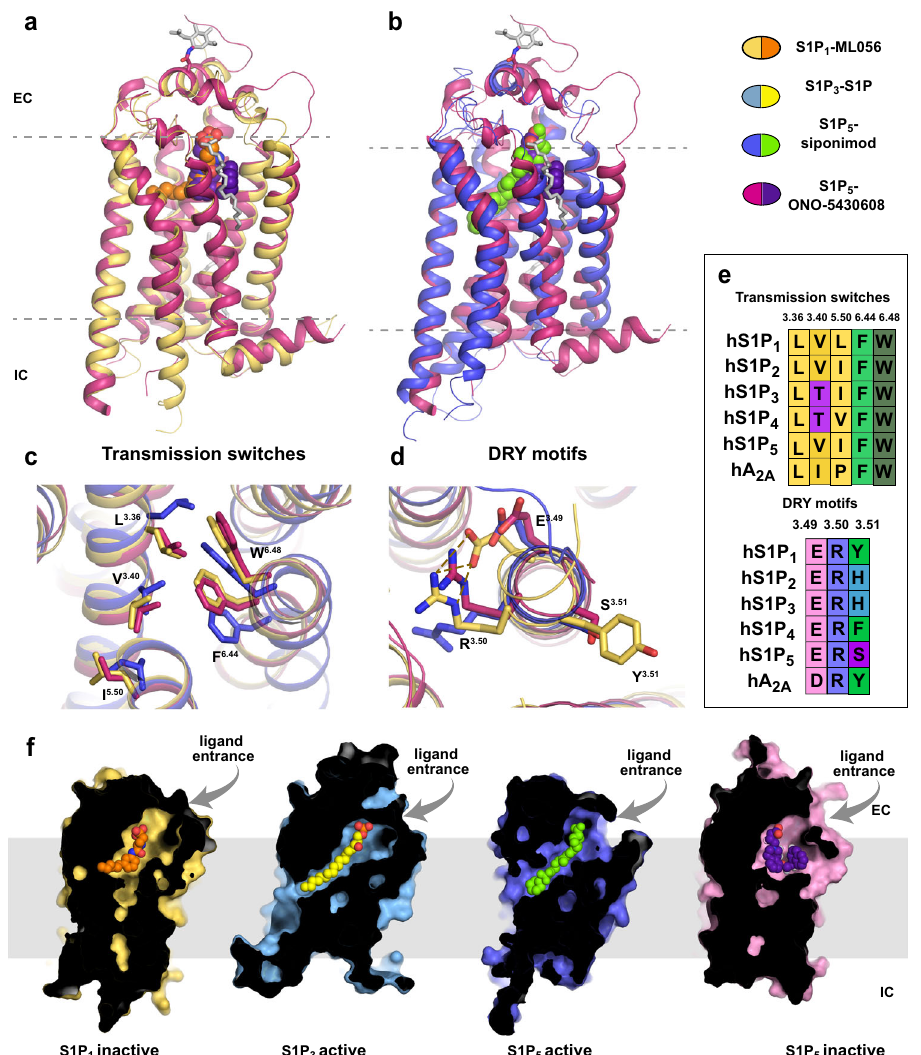
Fig. 1 | Structure of S1P 5 and its comparison with structures of other S1PRs: overview and conservative motifs. a Superposition of the obtained in this work inactive S1P 5 structure (pink cartoon) in complex with ONO-5430608 (purple spheres) with the inactive S1P 1 (yellow cartoon)-ML056 (orange spheres) complex (PDB ID 3V2Y). b Superposition of the inactive S1P 5 -ONO-5430608 with the active S1P 5 (violet cartoon)-siponimod (green spheres) complex (PDB ID 7EW1). Glyco- sylatedresiduesandlipidsobservedintheS1P 5 -ONO-5430608structureareshown as gray sticks. c Superposition of transmission switches for S1P 5 -ONO-5430608